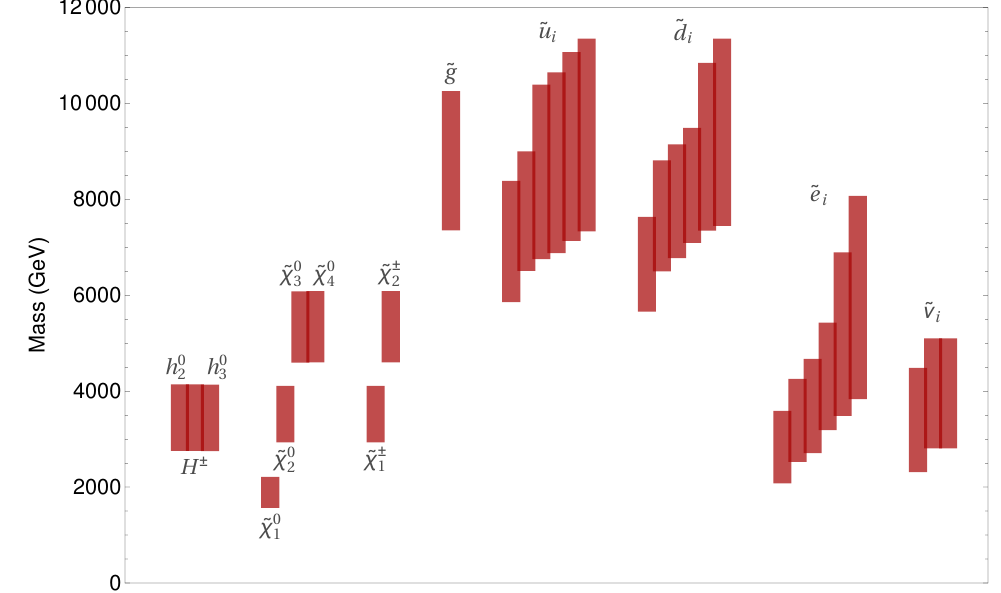
Figure 1 . 1 (cid:27) HPD intervals of the sparticle and the heavy Higgs boson masses. The LSP is always the neutralino ~ (cid:31) 0 and the NLSP is either a chargino, a stau or a sneutrino. 1